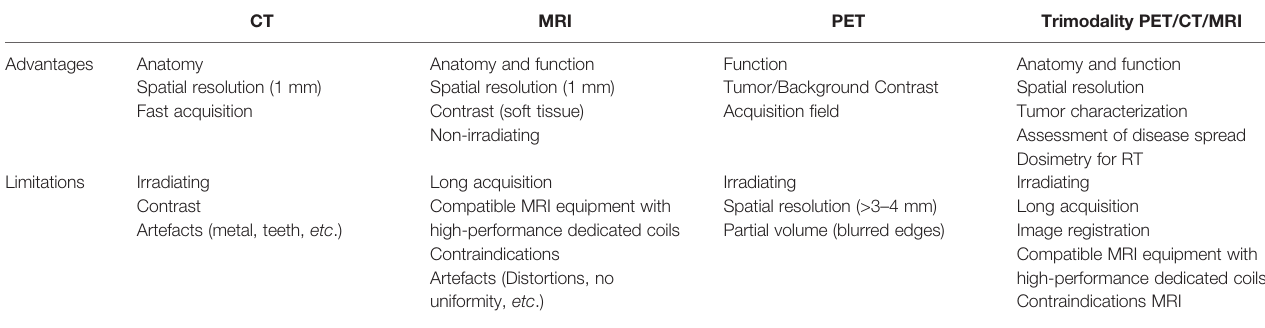
TABLE 1 | summary of the advantages and disadvantages of CT, MRI and PET separately and combined in PET/CT/MRI. CT